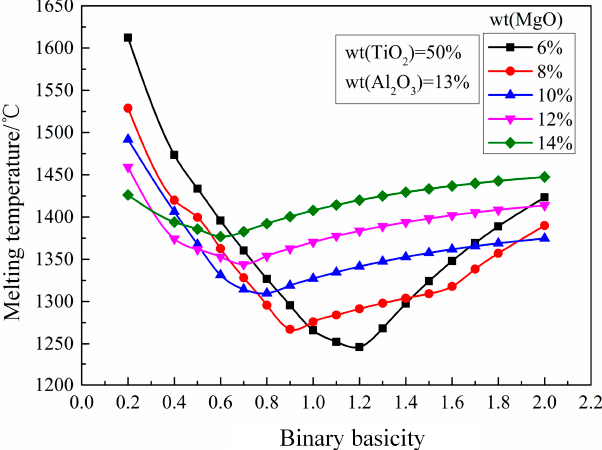
Figure 4. Effects of binary basicity and MgO content on melting temperature (FactSage 7.0).